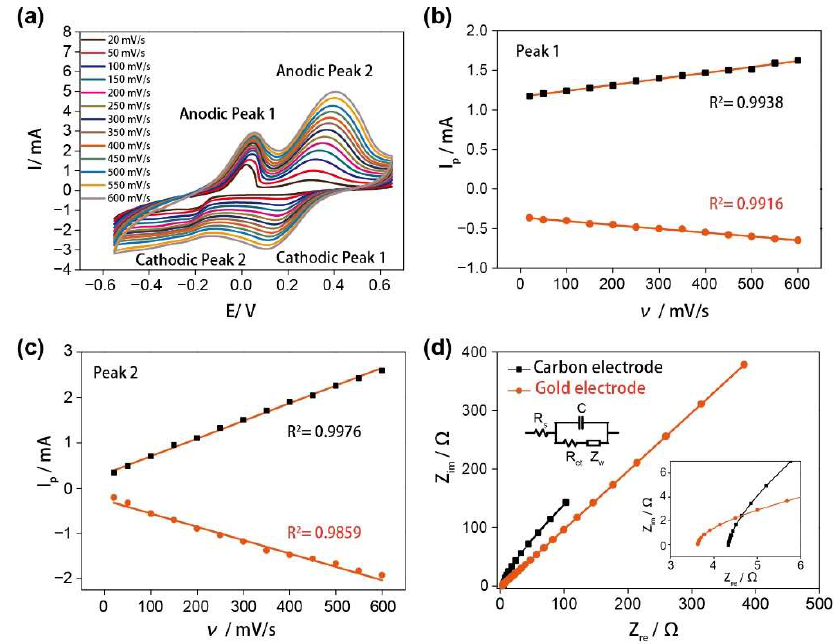
Figure 2. ( a ) Cyclic voltammograms for 4 mM CuCl 2 chelation agent in 100 μM glutamate in PBS at scan rates of 20, 50, 100, 150, 200, 250, 300, 350, 400, 450, 500, 550, and 600 mV/s; ( b ) currents of redox peak 1 obtained from ( a ) as functions of the scan rates; ( c ) currents of redox peak 2 obtained from ( a ) as functions of the scan rates; ( d ) Nyquist plots of carbon-based electrode and flat gold electrode in 10 mM PBS containing 100 μM glutamate and 4 mM CuCl 2 solution.